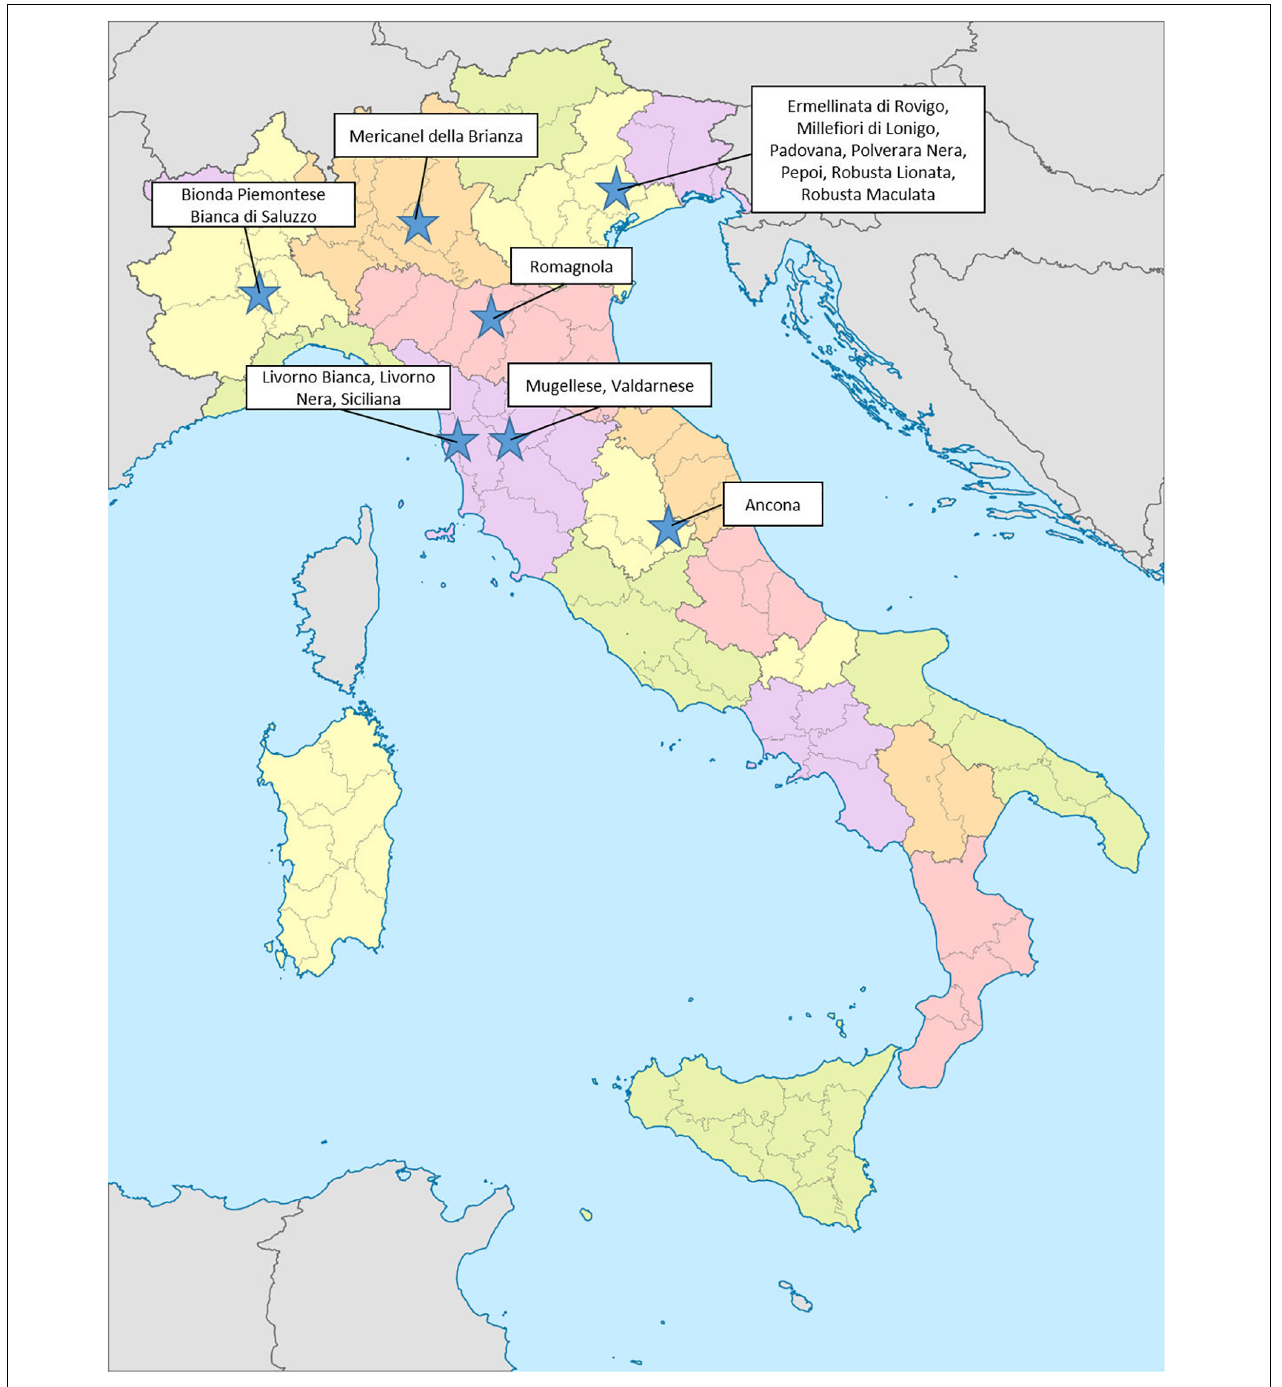
FIGURE 5 | Geographic localization of genetic conservation